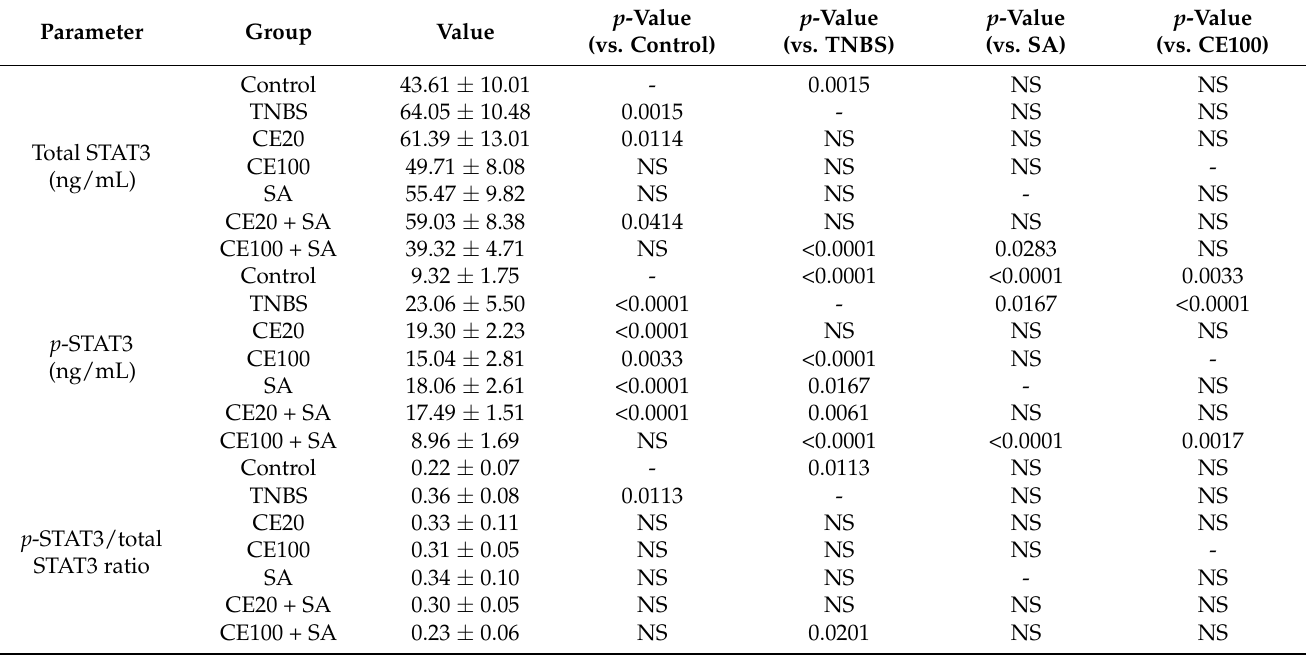
Table 1. The impact of cornelian cherry iridoid-polyphenolic extract on total STAT3 and activated (phosphorylated at Tyr705) STAT3 ( p -STAT3) levels in the colon tissues in experimental